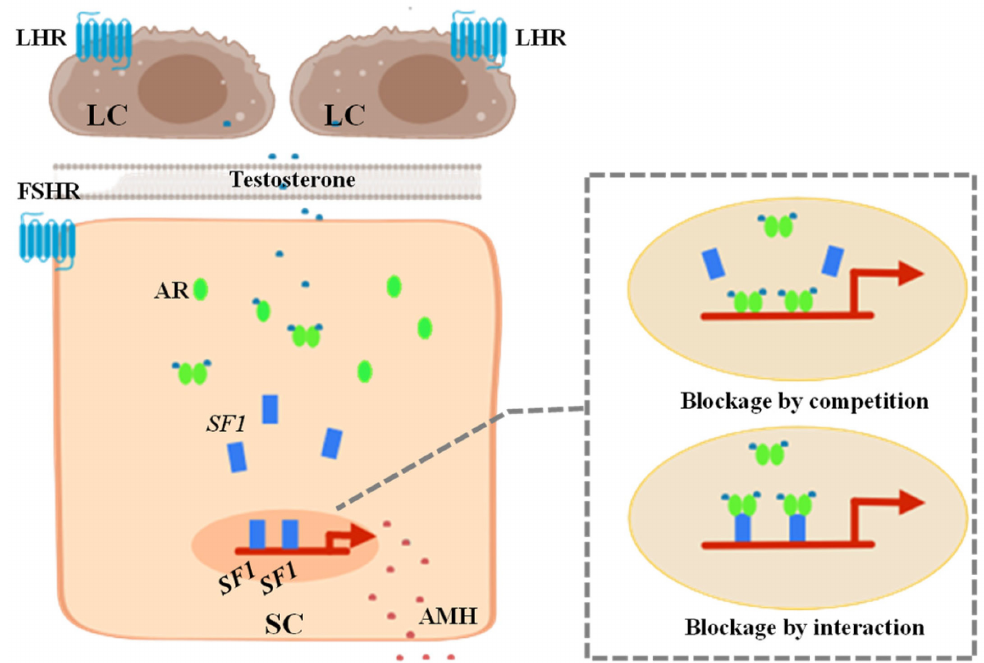
Figure 2. Mechanism of androgen receptor (AR) inhibiting the activity of anti-Müllerian hormone ( AMH ) gene promoter through SF1 in Sertoli cells (SCs). Androgen produced by the Leydig cells (LCs) enters SCs through biofilm and binds to AR to form a dimer that inhibits AMH gene transcription. (1) Blockage by competition may be that AR and SF1 compete for the binding site on the AMH gene promoter to prevent SF1 -mediated gene up-regulation and achieve androgen inhibition of the activity of the AMH promoter. (2) Blockage by interaction may be that AR binding to a site on SF1 changes the conformation of SF1 and prevent it from exerting its stimulatory effect on AMH promoter activity enabling androgen-mediated